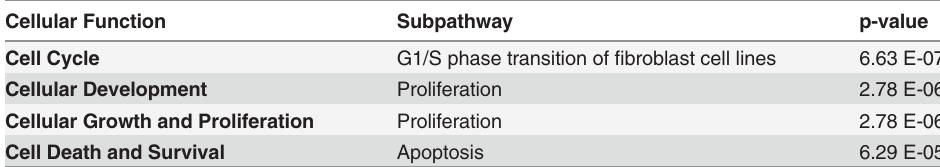
Table 3. Cellular functions significantly altered by Cfl2